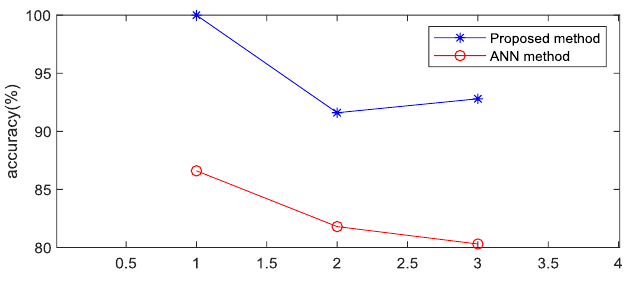
Figure 9. Comparison of the accuracies between the proposed method and the ANN method.